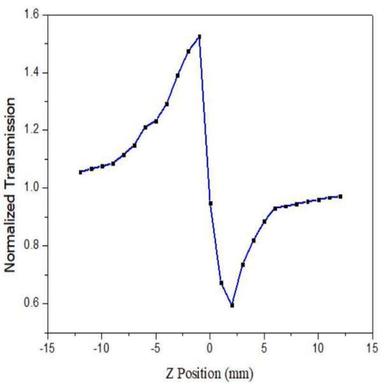
G4C3NBM crystal's closed mode Z-scan configuration.